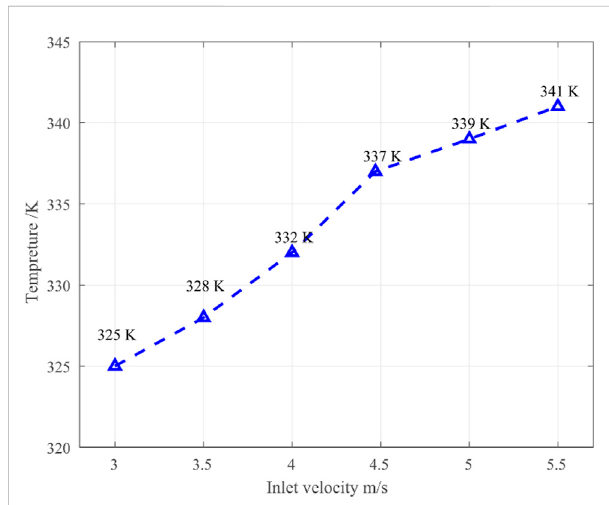
FIGURE 11 Lowest instantaneous temperature observed in the battery region at 2,400 s as a function of the magnitude of the inlet air fl ow velocity.